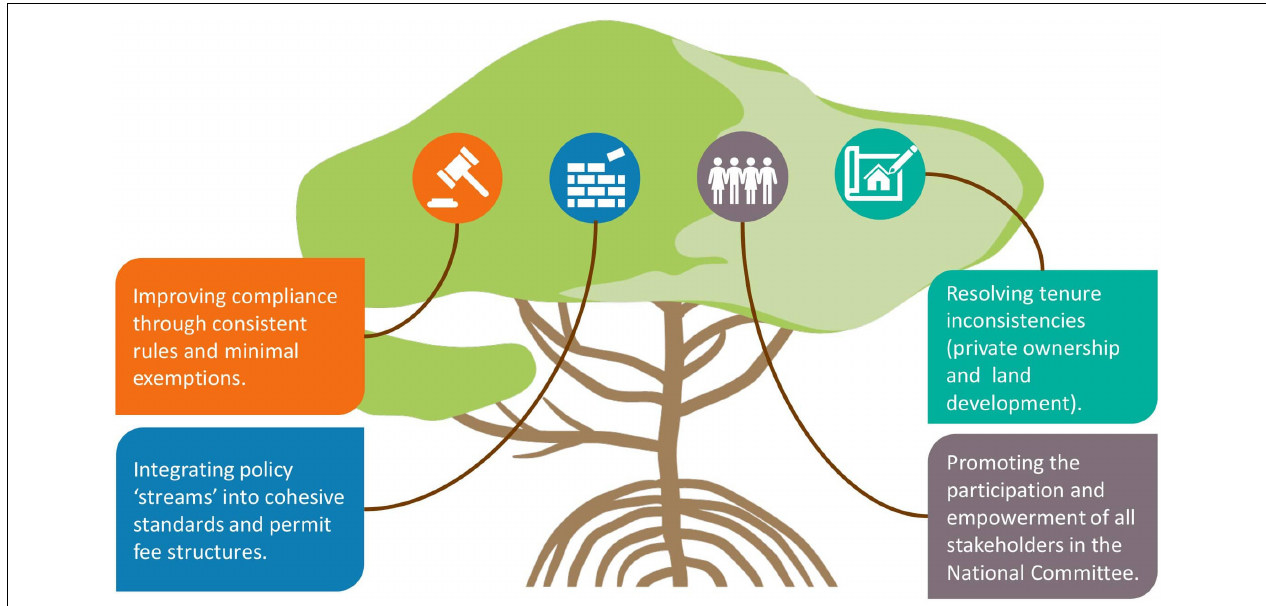
FIGURE 1 | Summary of policy barriers and pathways to foster sustainable mangrove management in Panama.